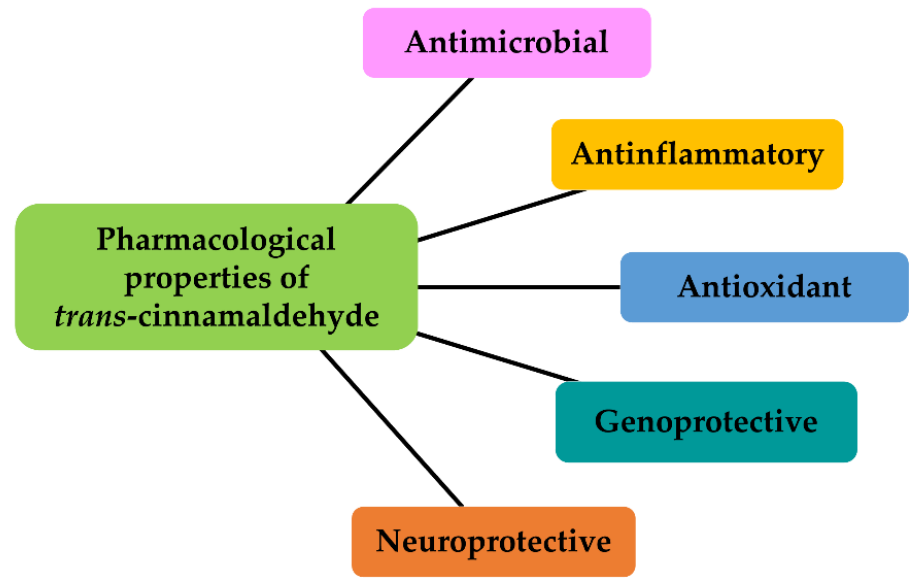
Figure 2. Pharmacological properties of cinnamaldehyde.